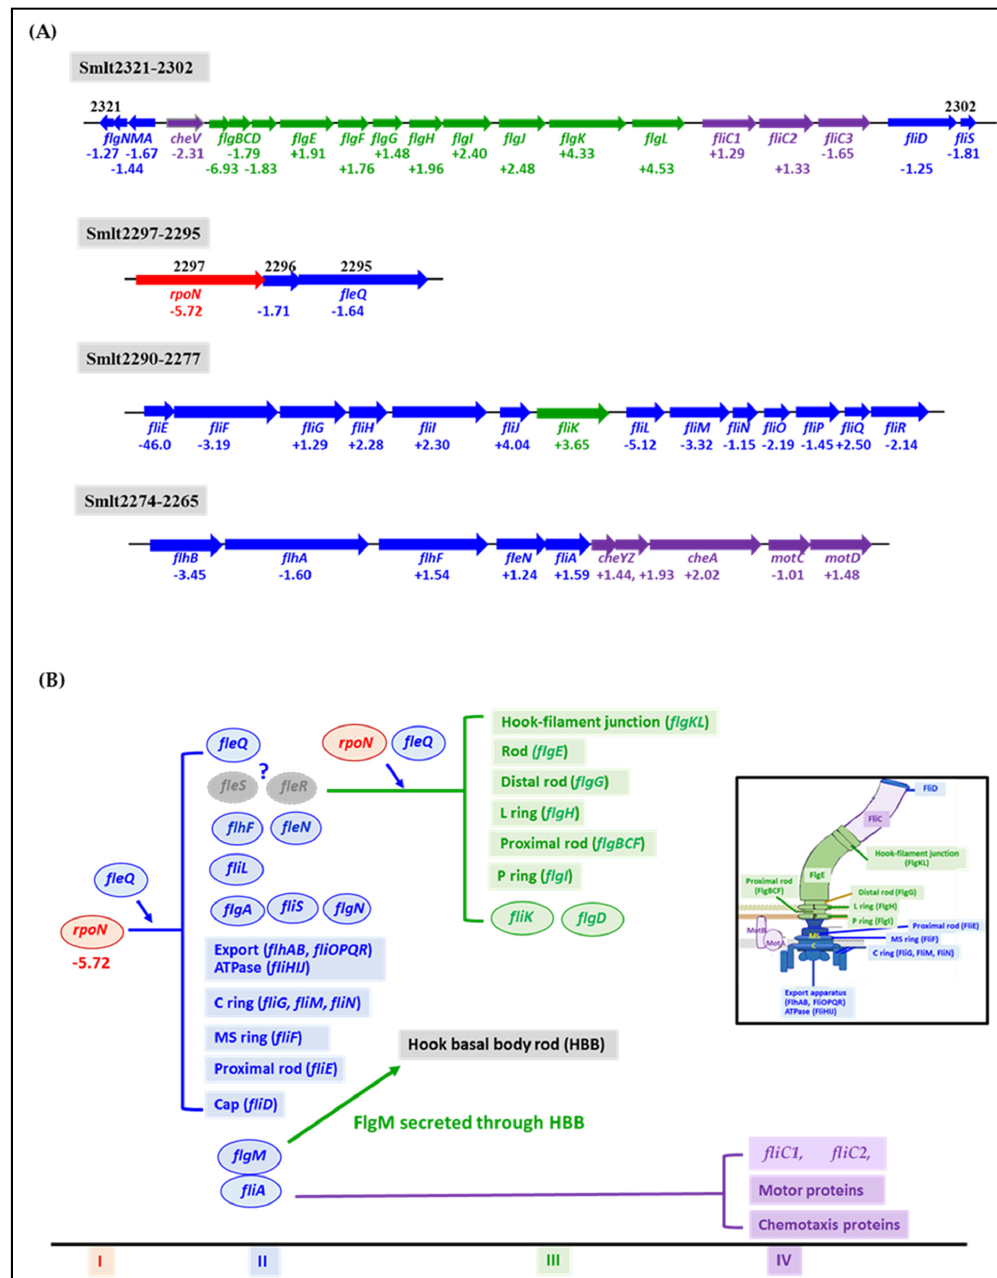
Figure 3. Flagellum synthesis model and RNA-seq transcriptome analysis of wild-type KJ and the ompA mutant, KJ ∆ OmpA. ( A ) Genomic organization of the genes involved in flagellum synthesis and action. The flagellum-associated genes were located in four clusters. The genes classified in class I, II, III, and IV are marked in red, blue, green, and purple, respectively. The numbers below the genes indicate the gene expression changes analyzed using a transcriptome assay. Positive values represent an upregulation in KJ ∆ OmpA, whereas negative values indicate a downregulation in KJ ∆ OmpA. ( B ) A schematic model showing the transcriptional hierarchy of the genes involved in flagellum synthesis in S. maltophilia. The flagellum synthesis model of S. maltophilia is proposed by referencing the known P. aeruginosa flagellum model, as most of the flagellum synthesis-associated genes of P. aeruginosa are highly conserved in the S. maltophilia genome. The genes classified in class I, II, III, and IV are marked in red, blue, green, and purple, respectively. The genes symbolized by rectangles represent the encoded proteins composing the flagellum and the ovals represent regulatory